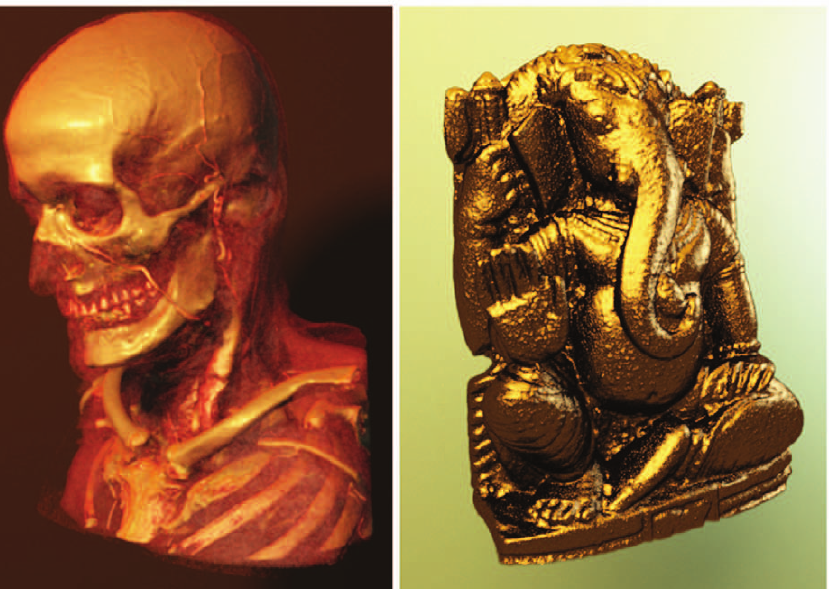
Figure 9. Left: Rendering of the publicly available Manix Data set (Osirix) with a photographic lighting setup. Right: By integrating physically based shaders into DVR, a wide spectrum of materials, for instance gold, can be simulated.